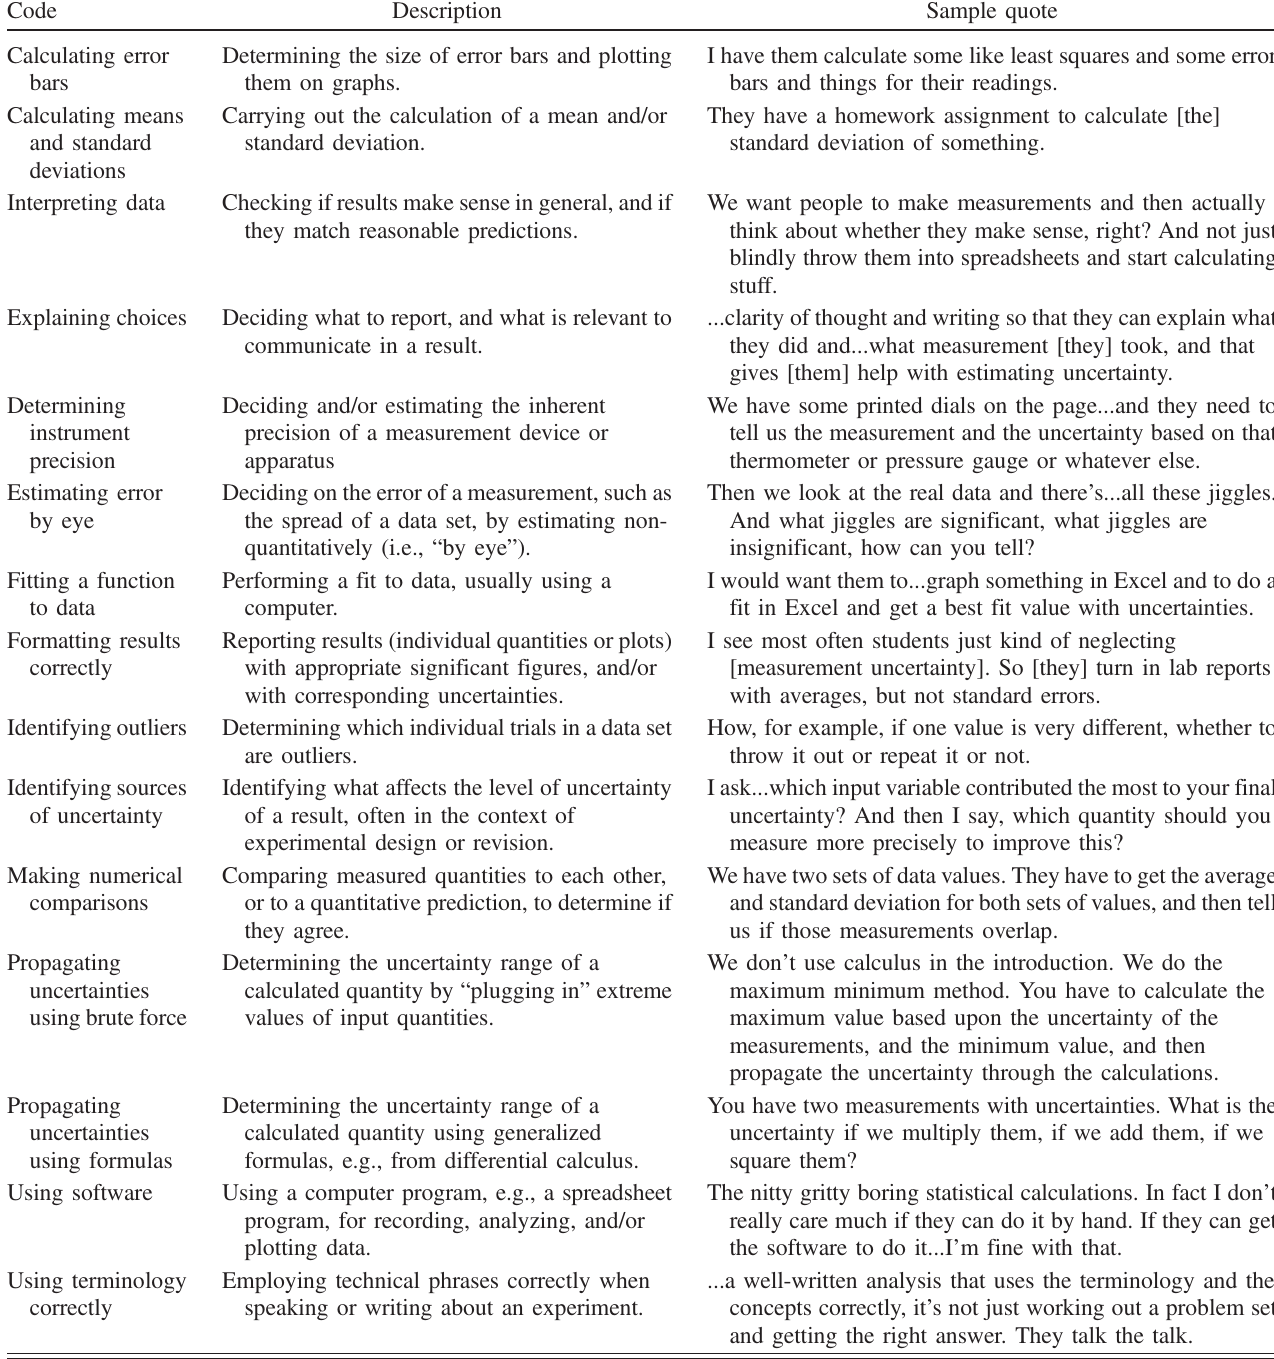
TABLE V. The set of emergent codes pertaining to measurement uncertainty practices. The first column is the name of the code, the second is a description of that code, and the third is an example excerpt from the